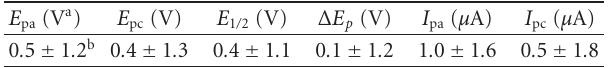
Table 1: Cyclic voltammetric data obtained for